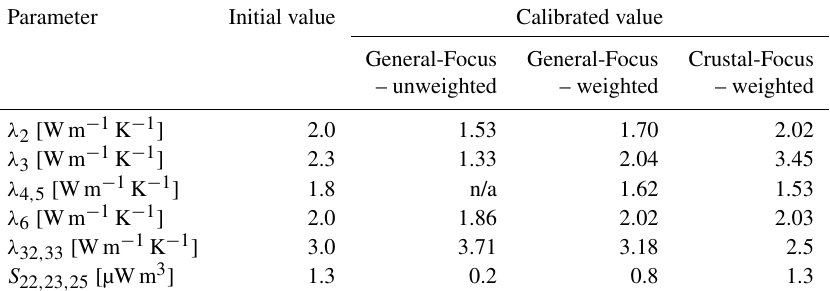
Table 2. Comparison of the initial thermal properties and the calibrated thermal properties for different geological models and different weighting schemes. The parameter that is not considered in the model calibration due to sensitivities that are too low is denoted with n/a.